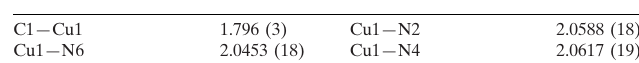
Selected bond lengths (A˚